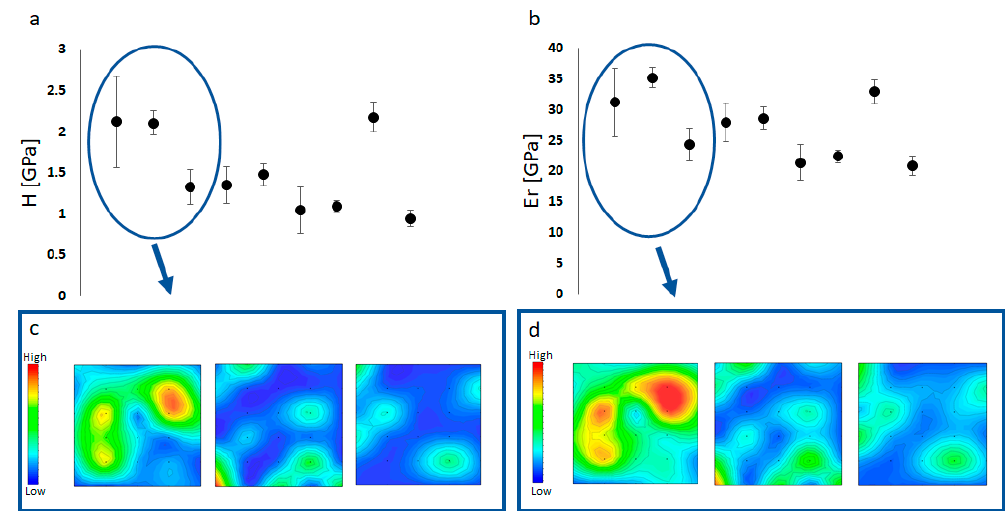
Figure 2. Mechanical properties of Pneophyllum cetinaensis measured by nanoindentation. ( a ) Hardness measurements of the nine specimens analysed (specimens in numerical order one–nine starting from the left to right along the x axes). ( b ) Elastic modulus measurements of the nine specimens analysed (specimens in numerical order one–nine starting from the left to right). ( c ) Hardness partial maps (15 × 15 indents) of specimens one to three (starting from the left) inside the blue oval in panel ( a ). ( d ) Elastic modulus partial maps (15 × 15 indents) of specimens one to three (starting from the left) inside the blue oval in panel ( b ). ( a , b ) Error bars = standard errors; X axes = specimens. ( c , d ) Colour legends are given in units of GPa where red is hardest ( c ) and stiffest ( d ). High variability within the same specimen ( c , d ) is also clearly visible in the maps, where peaks in hardness are shown in